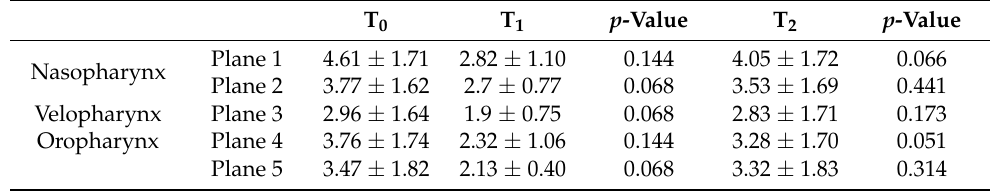
Table 3. Cross-sectional area (cm 2 ) in the different planes (mean + standard deviation (SD)).